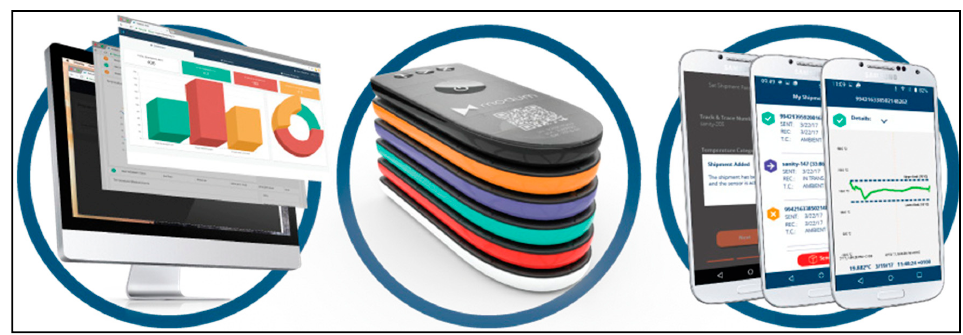
Figure 5. Components of the system from Modum are a dashboard, a temperature logger and a mobile application [40] (p. 6).